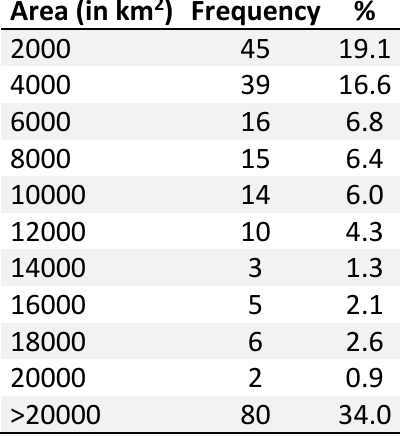
Table 3. Frequency and proportion of ethnographic hunter-gatherer groups, by territory size range. (Data taken from Binford 2001: Table